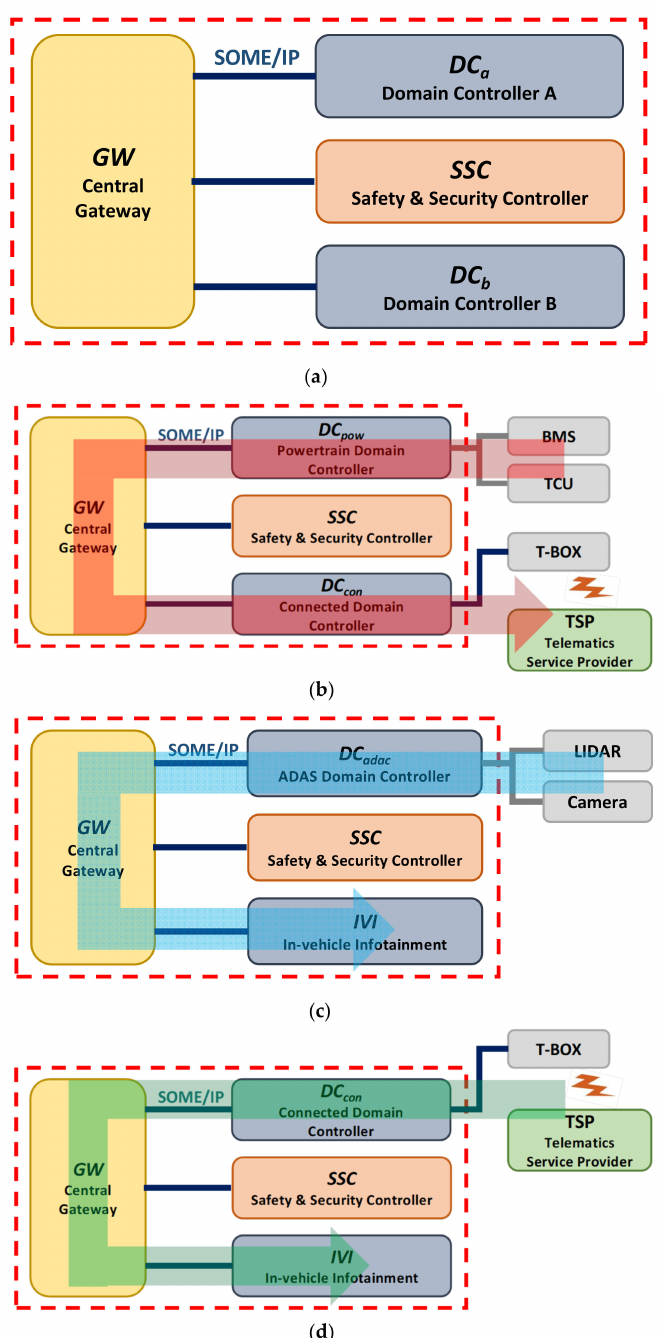
Figure 8. Application scenarios for the experiment evaluation. ( a ) Typical Ethernet-based communication structure. ( b ) Remote Monitoring scenario. ( c ) Parking Assistance scenario. ( d ) OTA upgrade